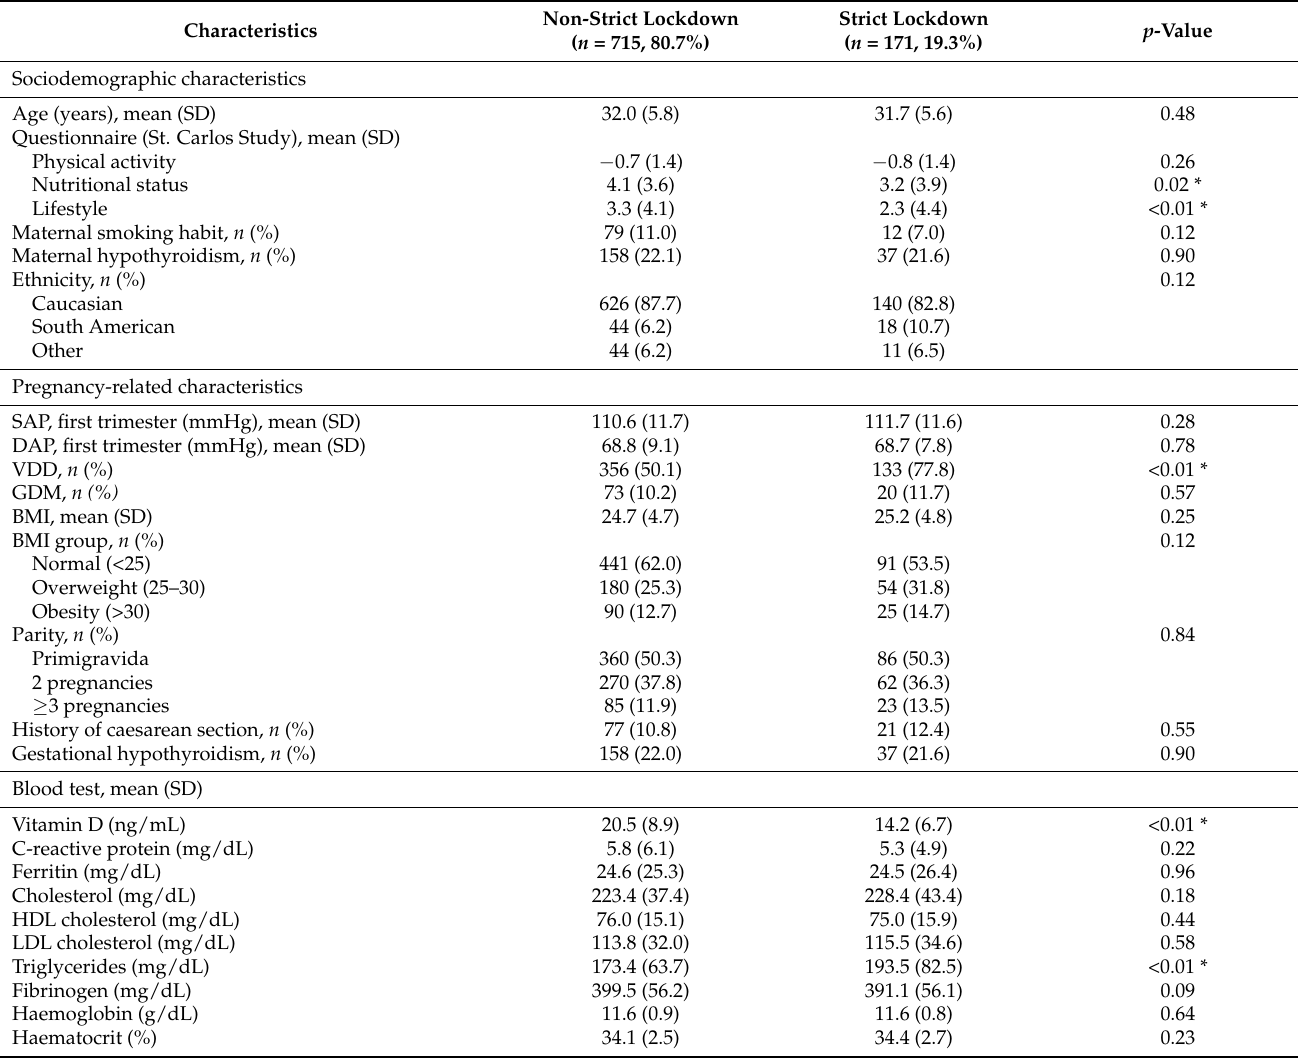
Table 1. Participants’ characteristics in relation to “Strict Lockdown” status